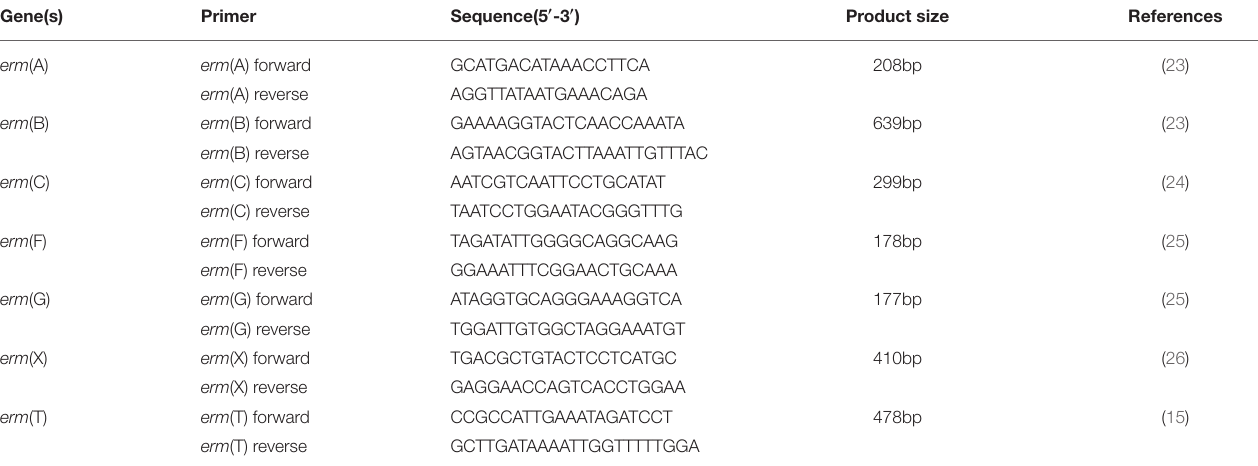
TABLE 1 | Primer pairs used in this